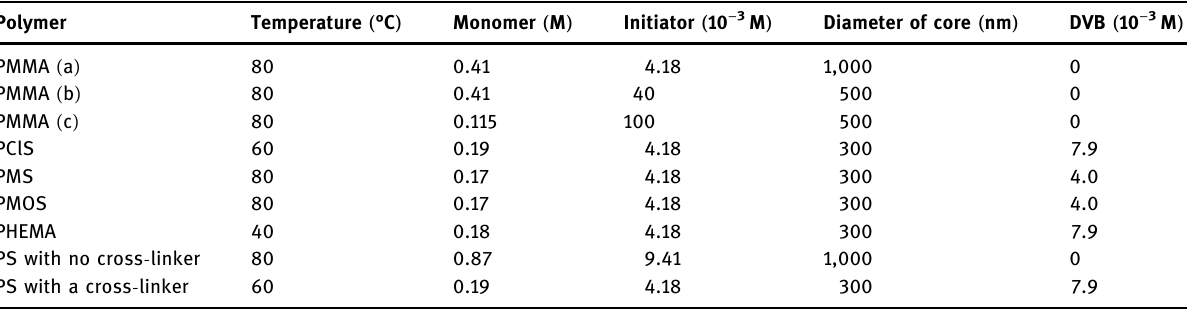
Table 1: Optimized conditions for emulsion polymerization